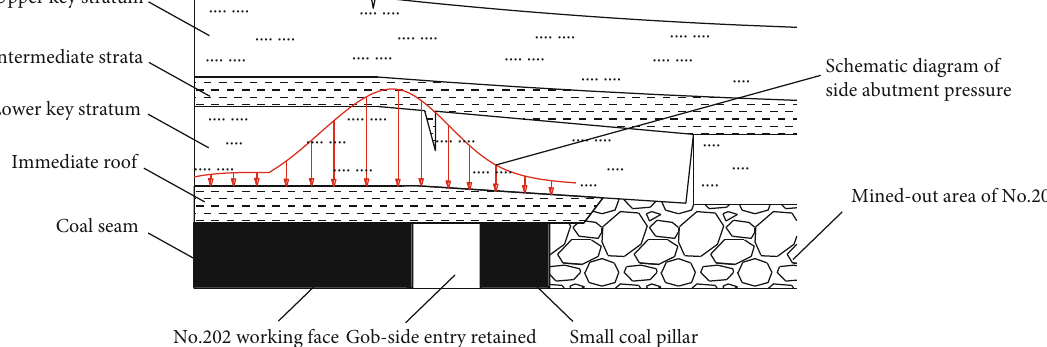
Figure 1: Distribution giagram of abutment pressure before roof cutting.